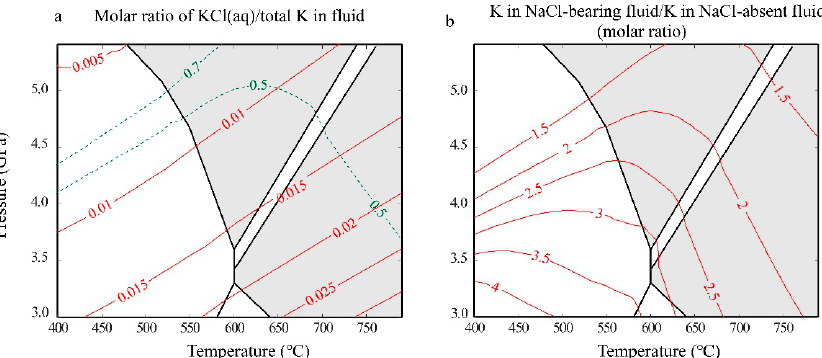
Figure 3. The effect of fluid chlorine in the dissolution of K. ( a ) Molar ratio of KCl(aq)/total K in the fluid with 2 wt.% of dissolved NaCl. ( b ) The molar ratio between K solubility in NaCl-bearing fluids and that in NaCl-absent fluid.